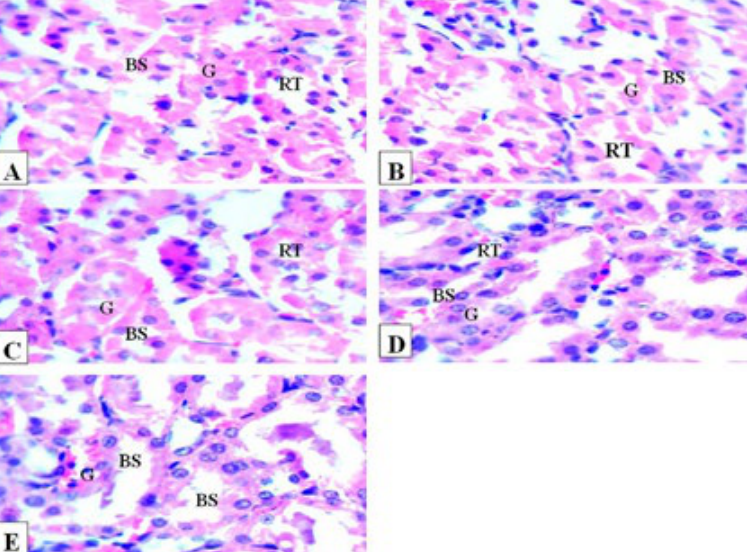
FIGURE 4 - Recovery kidney sections photomicrographs showing; Plate A (Control), Plate B (62.5 mg/kg), Plate C (125 mg/kg), Plate D (250 mg/kg), Plate E (500 mg/kg). G: Glomeruli, BS: B owman’s space, RT: Renal TABLE IX - Effect of sub-chronic administration of Dryopteris filix-mas ethanol leaf extract on body weight of albino rats. Body weight gain (%) Control